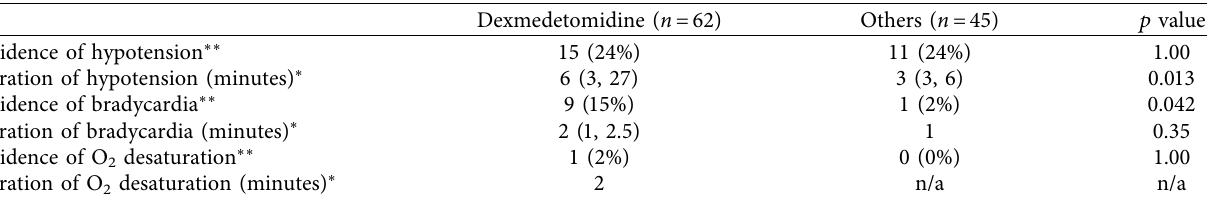
2 desaturation with dexmedetomidine versus other IV